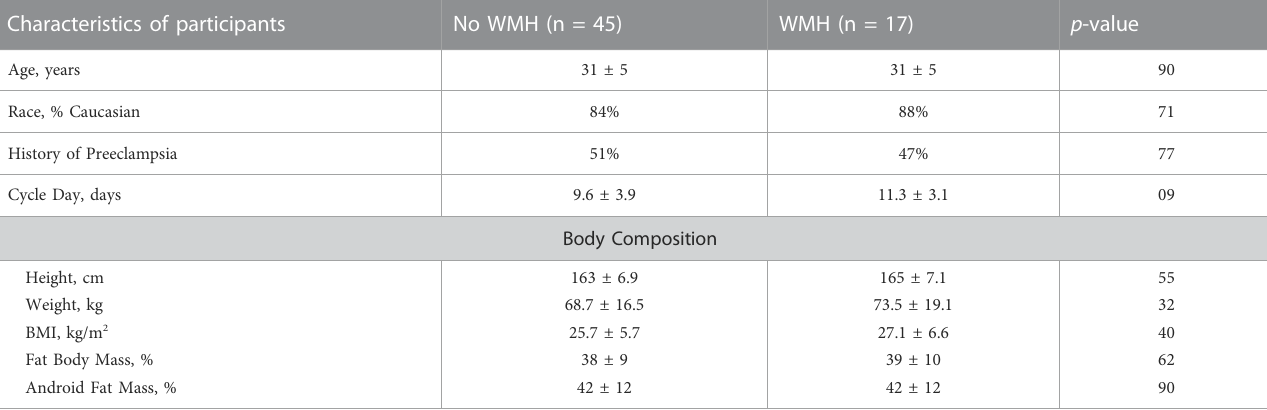
TABLE 1 Comparisons of demographic, physical, and anthropomorphic observations between women with and without evidence of white matter hyperintensities. Data are presented as mean ± standard deviation or frequency. Characteristics of participants